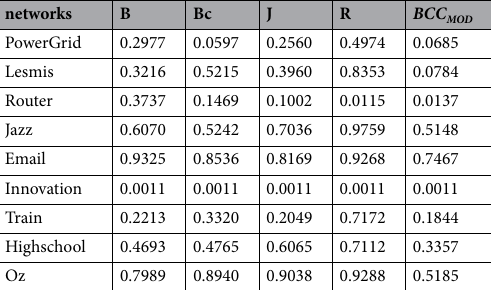
Table 2. The value of p corresponding to the largest S .